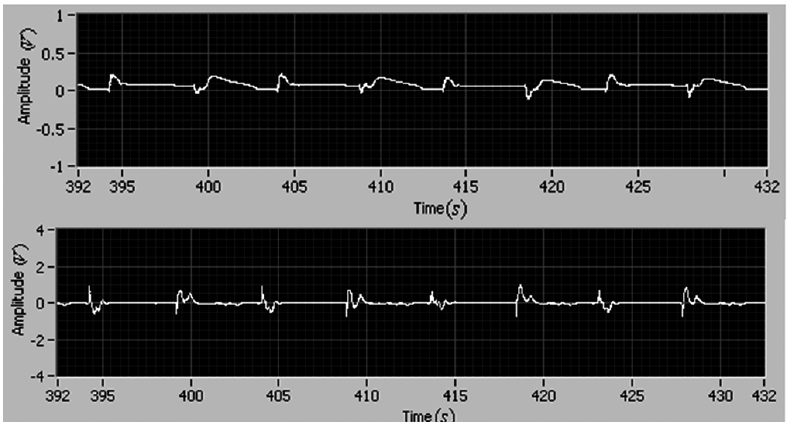
Figure 13. Tracking errors of position ( top ) and velocity ( bottom ).